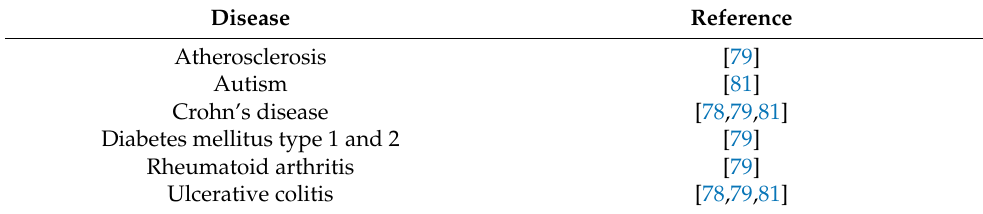
Table 2. Diseases for which dysbiosis is a crucial